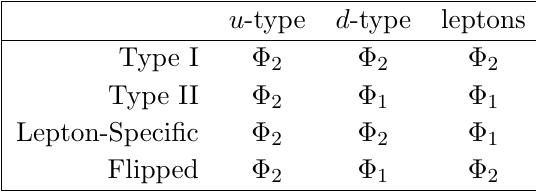
-symmetric 2HDM. 2